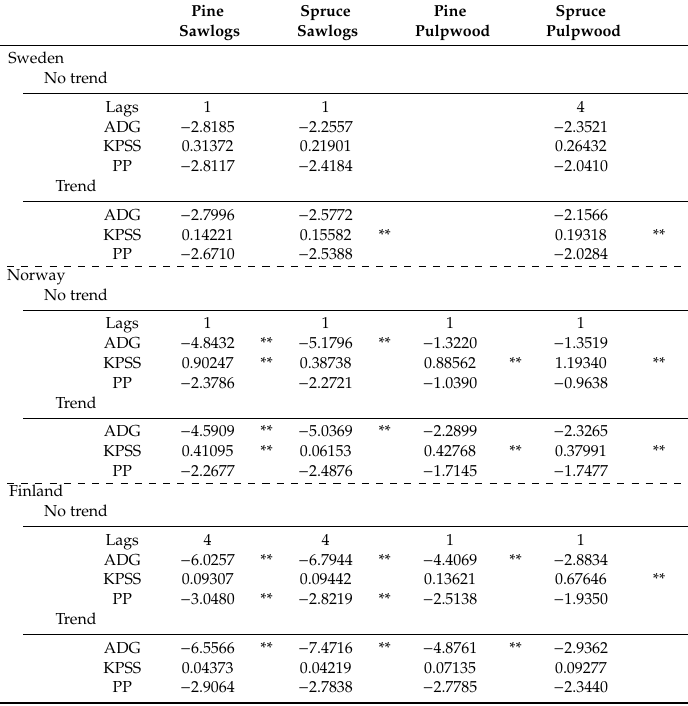
Pine Spruce Pine Spruce Sawlogs Sawlogs Pulpwood Pulpwood